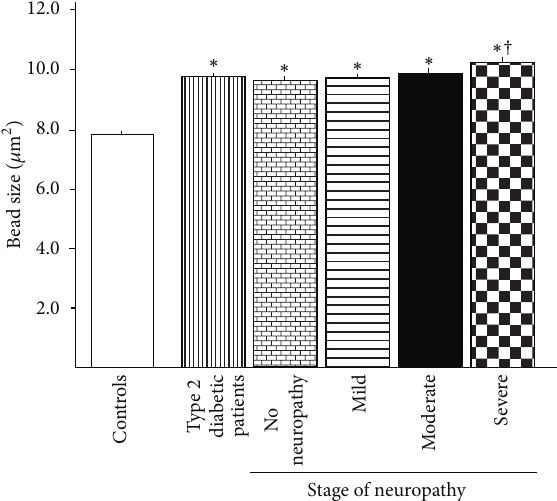
Figure 1: Comparison of the bead sizes of the corneal nerve fibers between control subjects, total type 2 diabetic patients, and diabetic subgroupsstratifiedbytheseverityofneuropathy.Dataarethemean ± SEM. ∗ 𝑝 < 0.001 compared with control subjects and † 𝑝 < 0.05 compared with patients without